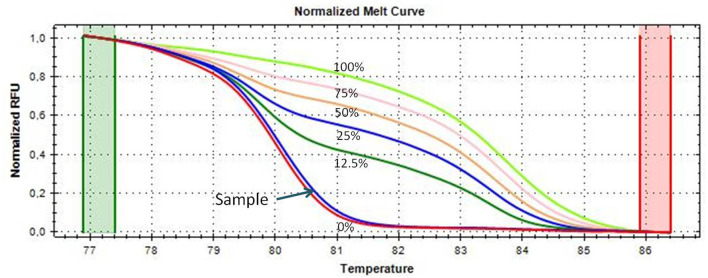
Melting curves of the CDKN2A gene generated by samples with known methylation levels (0, 12.5, 25, 50, 75, and 100% methylation, respectively), obtained by mixing the fully methylated and unmethylated standard DNA samples. A thymoma sample showing almost 0% promoter methylation is shown and indicated with an arrow; its melting curve is very similar and partially juxtaposed to that of the completely unmethylated standard DNA (red curve).